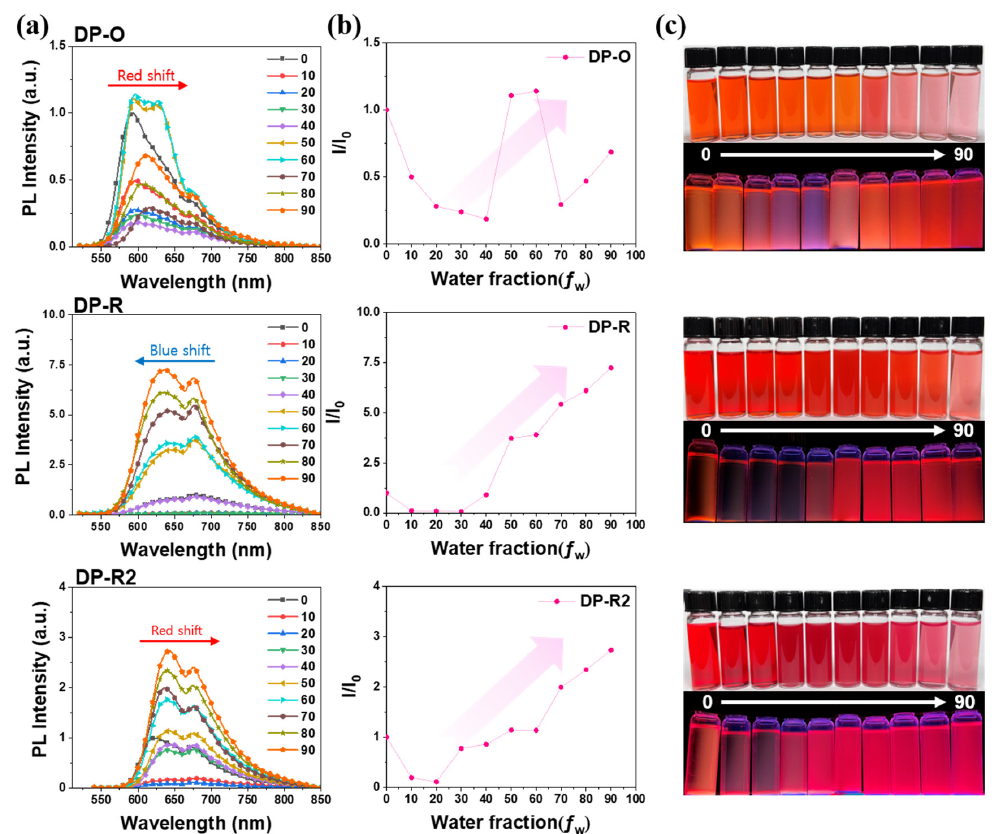
Figure 1. ( a ) PL spectra, ( b ) intensity change of maximum emission wavelength, and ( c ) photo ‐ graphs by water fraction ( f w ) of DPP ‐ based AIE dyes. (Excitation wavelength = 365